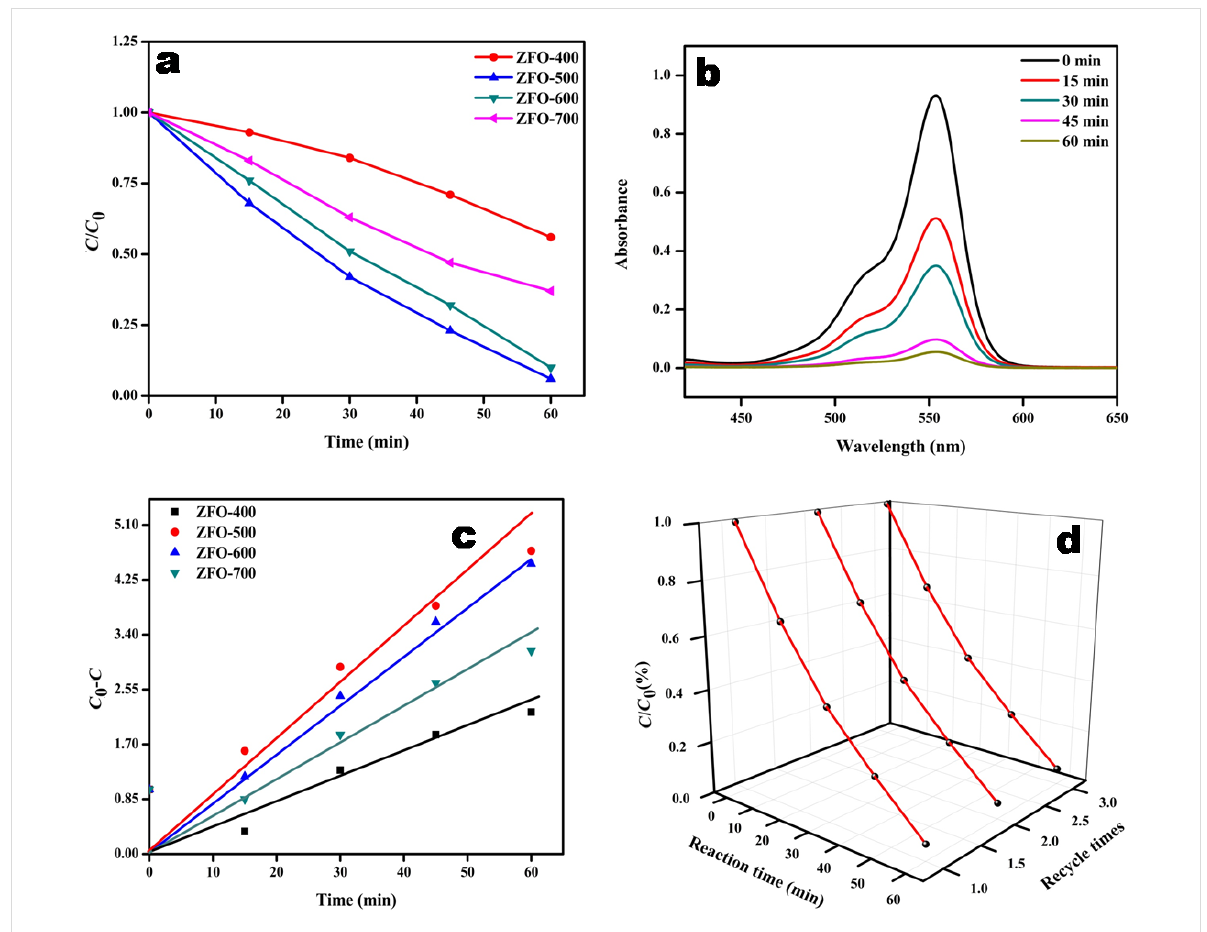
Figure 12: (a) Rate of decolourization of 5 ppm Rh B over ZFO samples; (b) spectral changes of Rh B over ZFO-500 after different time intervals; (c) zero-order kinetics plot of Rh B decolourization over ZFO samples; (d) stability graph of ZFO-500.